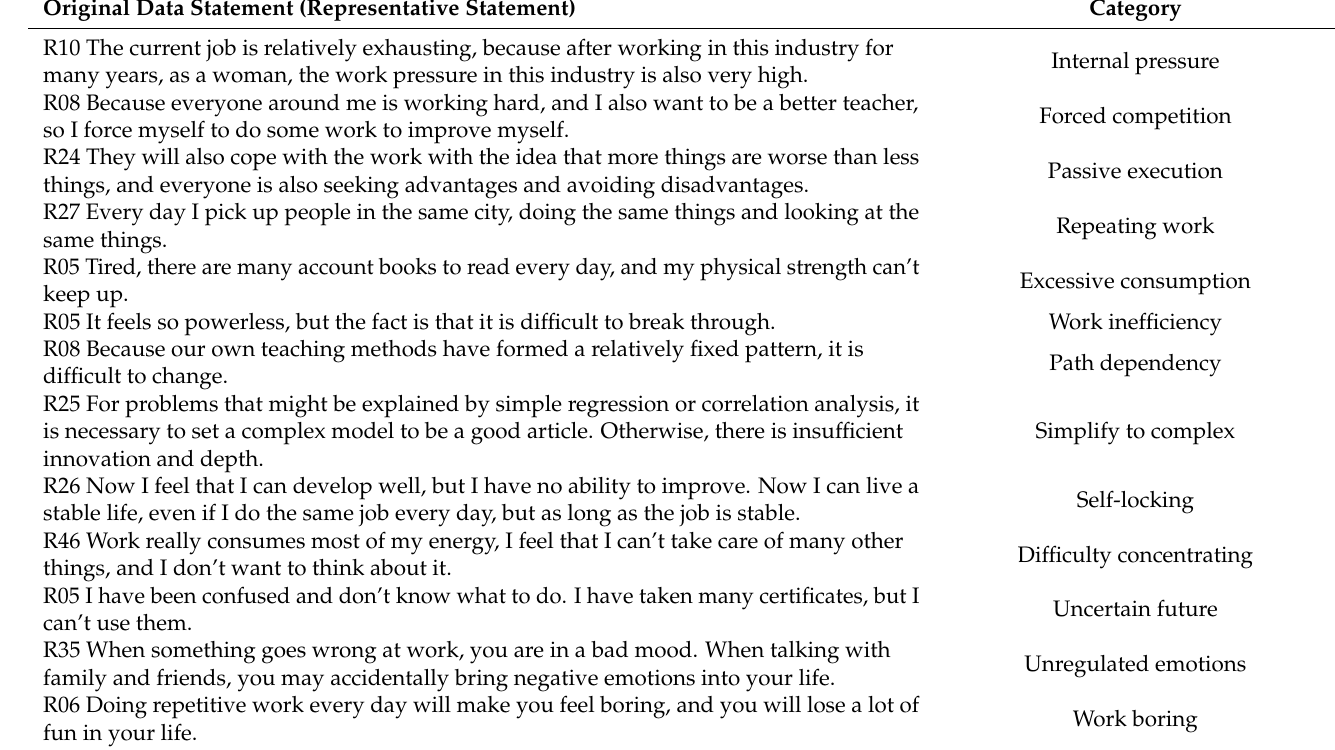
Table 3. Process and Results of Open Coding